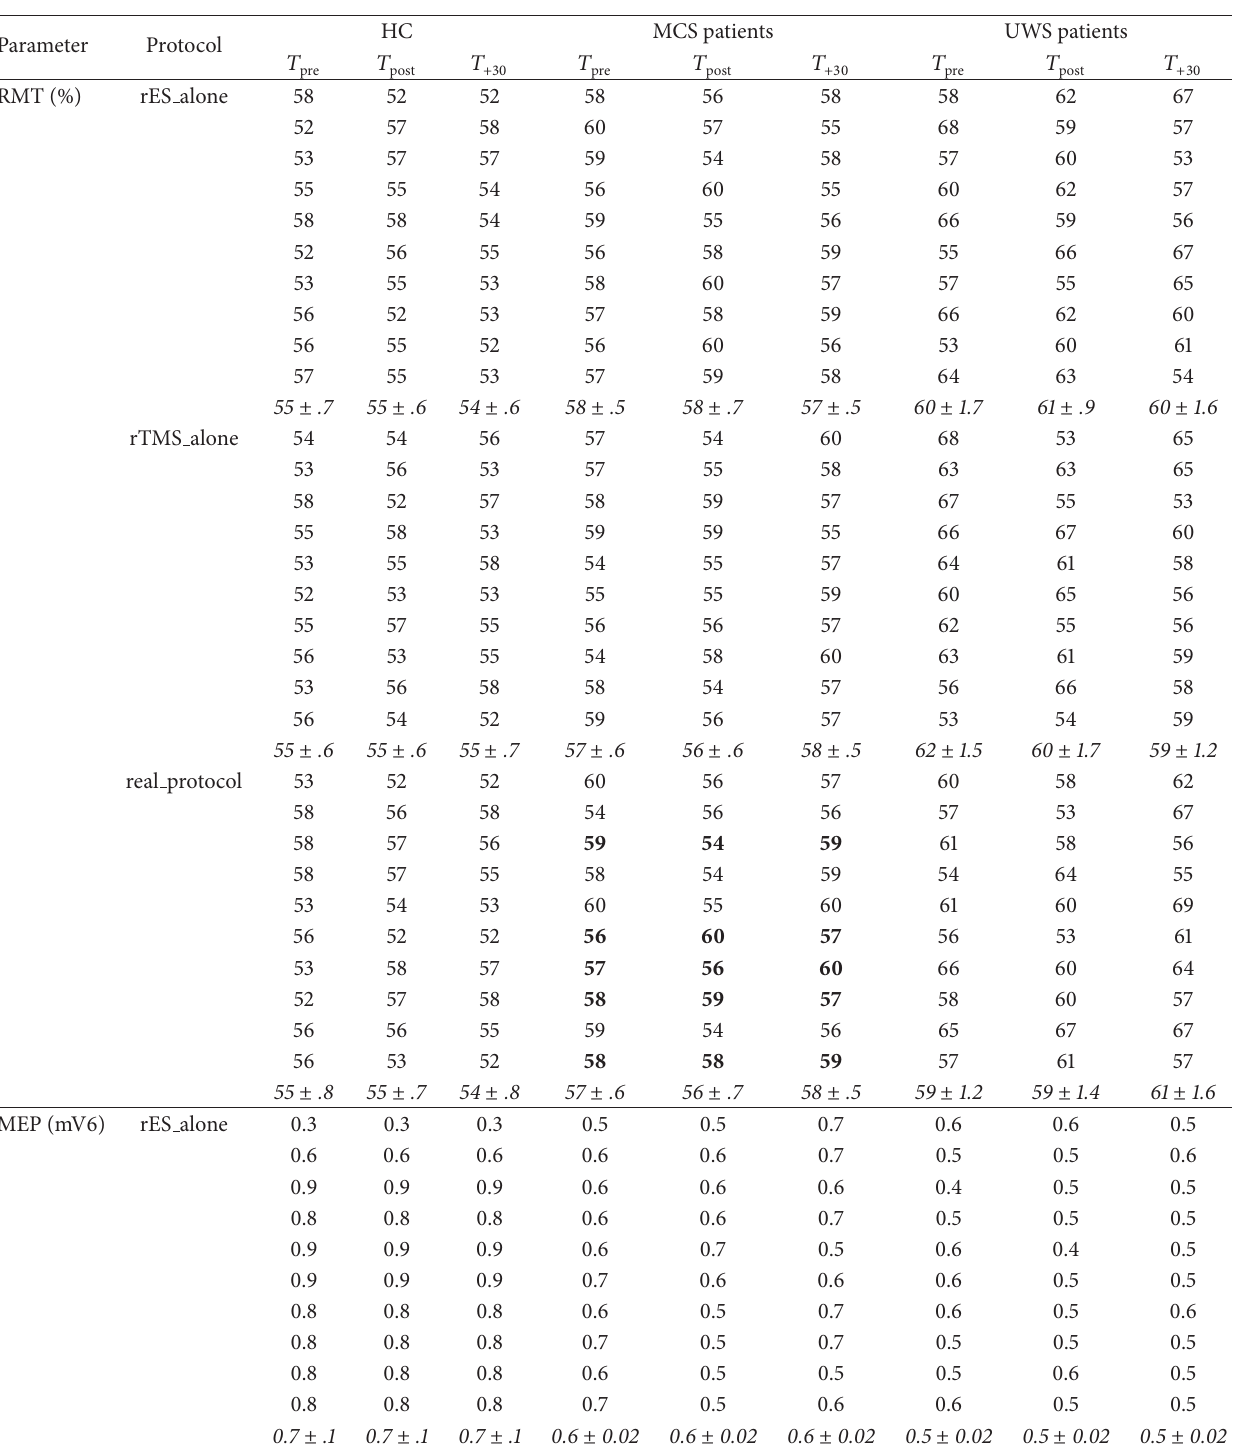
Table 2: The time course of the individual raw values of the electrophysiological parameters in the HC and MCS and UWS participants. , there were not significant differences among the three groups concerning RMT% and MEP amplitude. MCS displayed partially At 𝑇 pre preserved audiomotor connectivity, although weakened (i.e., increased AMI). The UWS showed instead markedly weakened AMI and a global impairment of cortical excitability, connectivity, and LLAEP N1 latency and amplitude (increased and decreased, resp.). Data are summarized as mean ± se (in italic ). The MCS patients who ameliorated at the auditory function ( 𝑛 . 3, 6, 7, 8, and 10) at 𝑇 real protocol are marked in